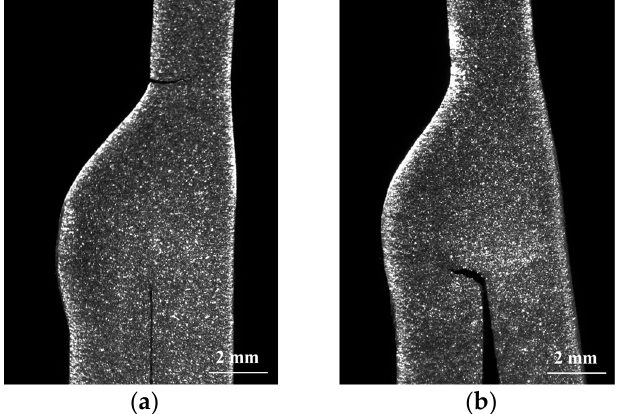
Figure 8. The location of fatigue crack initiation of ( a ) type 2 sample at max. stress of 92 MPa and ( b ) type 2 sample at max. stress of 366 MPa.